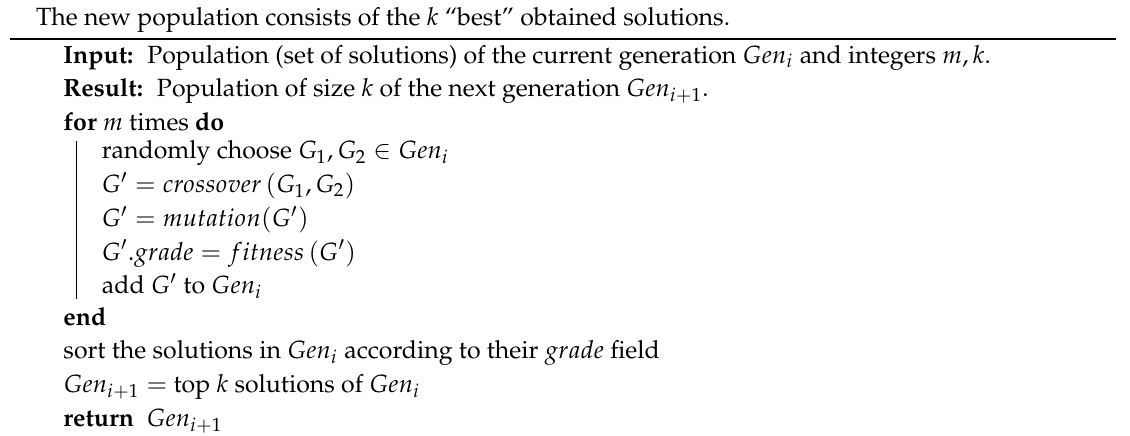
Algorithm 4: Pseudocode of nextGeneration , which creates the population of the next generation by applying the crossover and mutation operators on solutions from the previous generation. The new population consists of the k “best” obtained